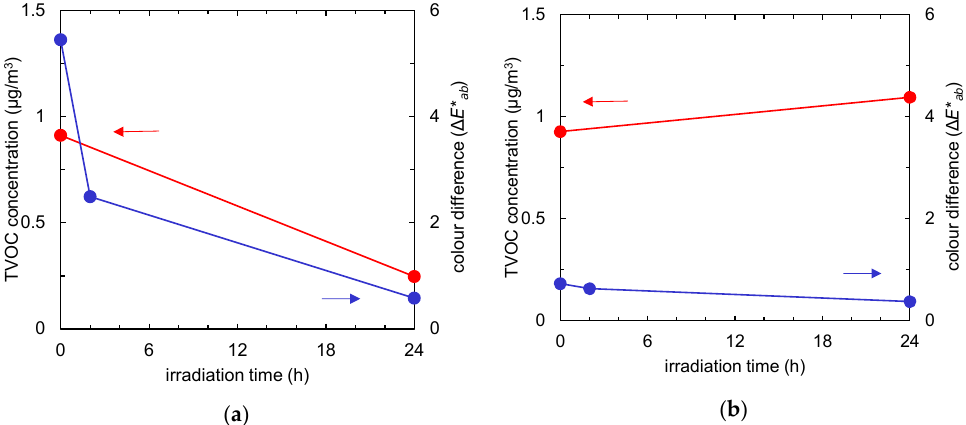
Figure 4. Time course of total volatile organic compound (TVOC) concentration (red) and colour difference (the ∆ E * ab value compared to the colour of the fabric before tobacco smoke adsorption, represented in blue) of the fabrics after tobacco smoke adsorption vs. UV irradiation time. ( a ) Non ‐ woven fabric with TiO 2 ; ( b ) non ‐ woven fabric without TiO 2 .